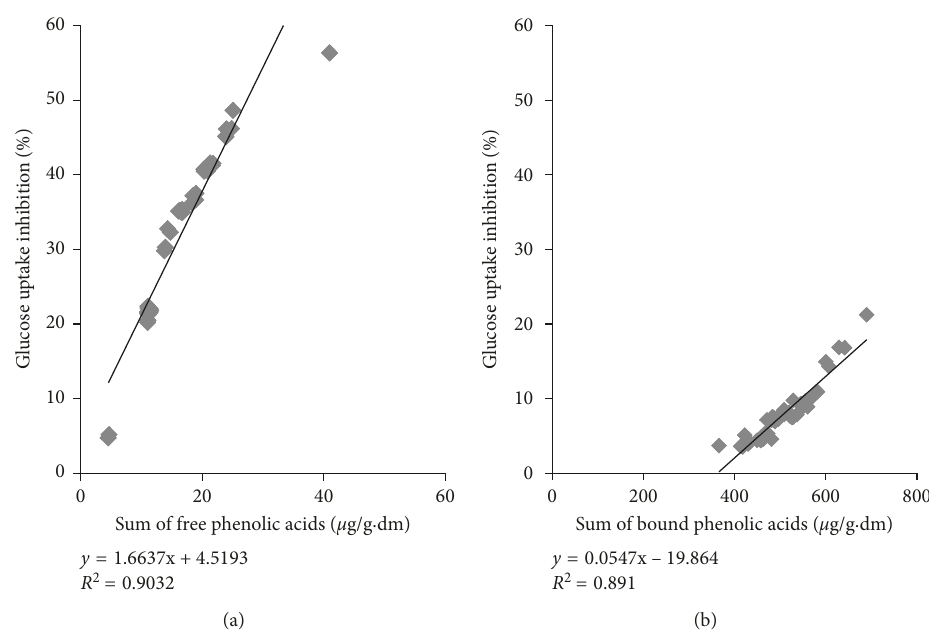
Figure 3: Correlation between the relative inhibition of glucose uptake into CaCo-2 monolayers and free phenolic acid (a) and bound phenolic acid (b) contents in extracts of eight wheat genotypes grown in MB, SK, and AB over 2011 crop